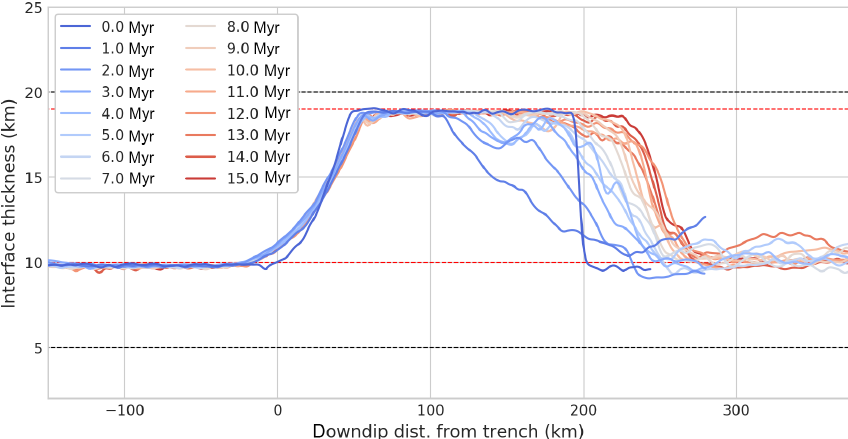
Figure 8. Interface thickness evolution, EF approach. In the EF implementation limits are imposed in the maximum and minimum thick- nesses, as shown by the red dashed lines. Unlike the standard WL approach, the initial thickness of the interface is variable. The initial thickness of the interface within the decoupling region is equal to W max . The black lines show the typical range in which a WL model will vary, assuming a constant initial thickness of 10km (see also Fig. 4). The results shown here refer to the same model as shown in Figs. 1 and 6.